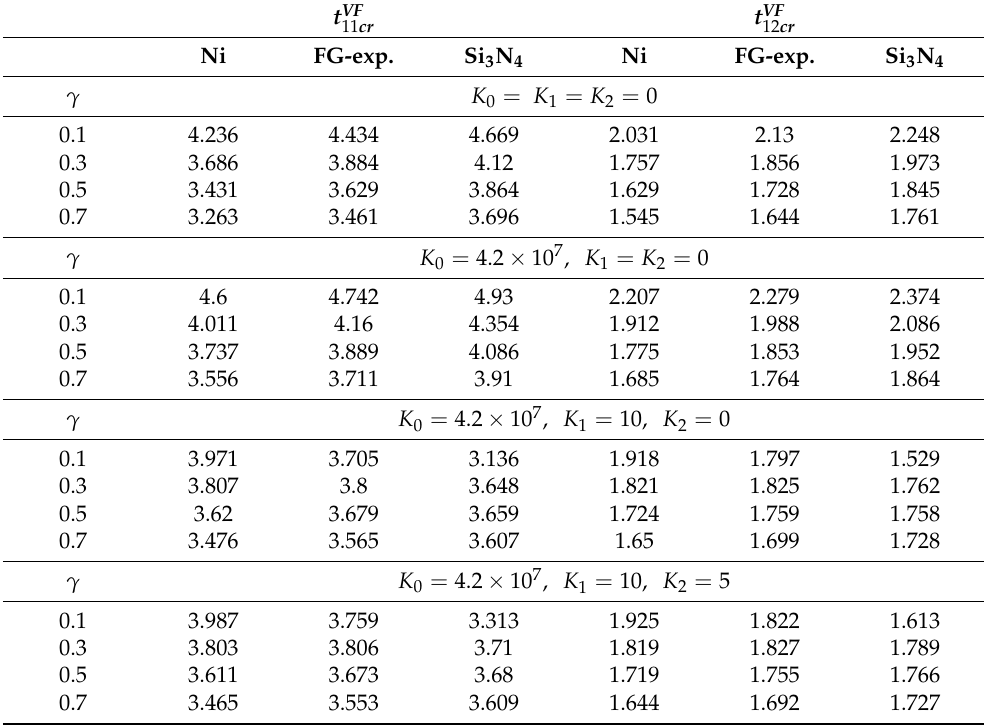
Table 1. Changes of critical times of FG-VE-Ps on VE-Fs depending on the viscoelastic parameter γ with FIC and SIC ( h / a = 0.02, b = 0.5 a , p VF =